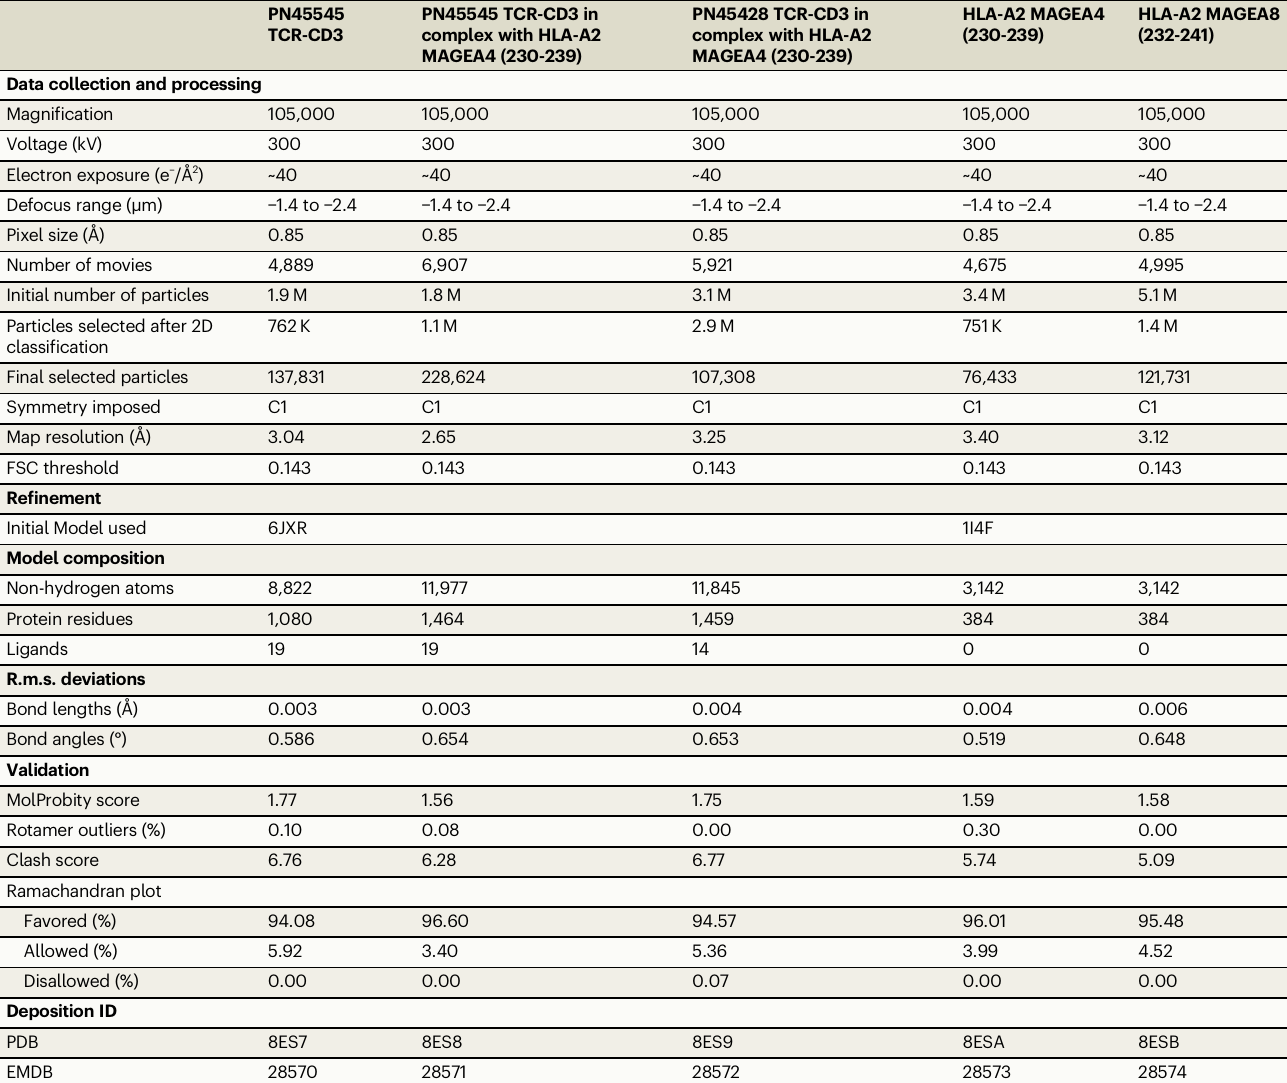
Table 1 | CryoEM data, structure re fi nement, and